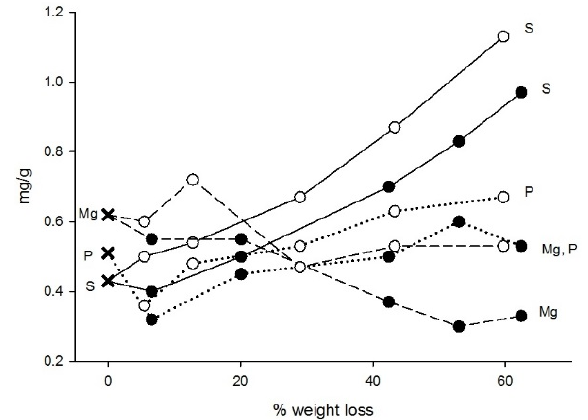
Figure 8. Changes in the concentration of sulphur (solid lines), magnesium (stippled lines) and phosphorus (dotted lines) during decomposition of cones. Filled circles: moss habitat. Open circles: needle mat habitat.